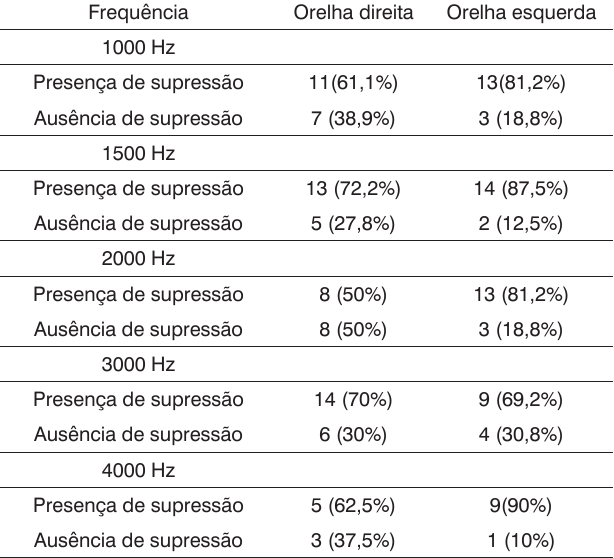
Tabela 1. Ocorrência do efeito de supressão das EOATs por faixa de frequência nas orelhas direita e esquerda em sujeitos normo-ouvintes com zumbido e hiperacusia.